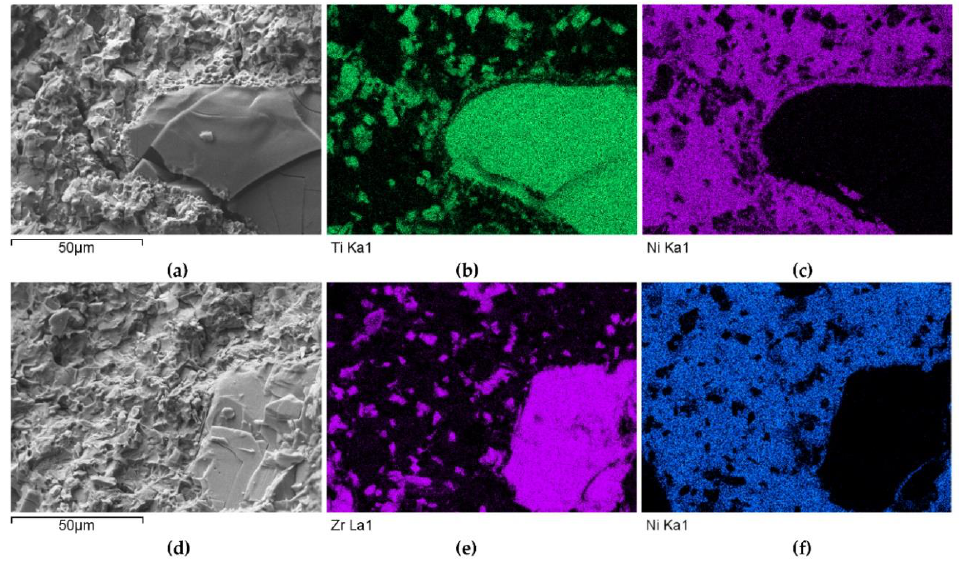
Figure 6. SEM/EDS micrographs of fractured surfaces of NiBSi-TiC ( a – c ) and NiBSi-ZrC ( d – f ) composite welds enabling phases